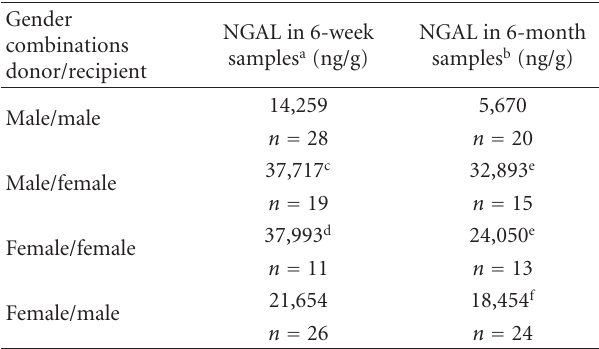
Table 4: Correlation of uNGAL ratios to the di ff erent donor/ recipient gender